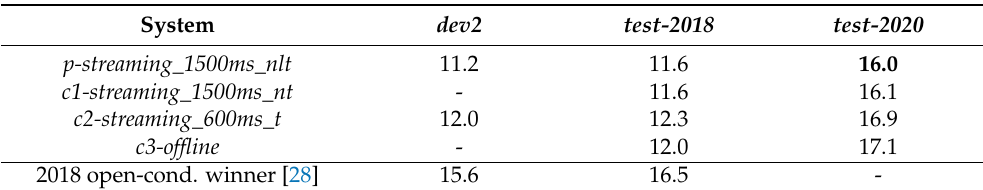
Table 5. WER of the participant systems, including our open-condition system submitted to the 2018 challenge, computed over the dev2 , test-2018 and test-2020 sets. In bold, the result from our primary submission in the contest main test set test-2020